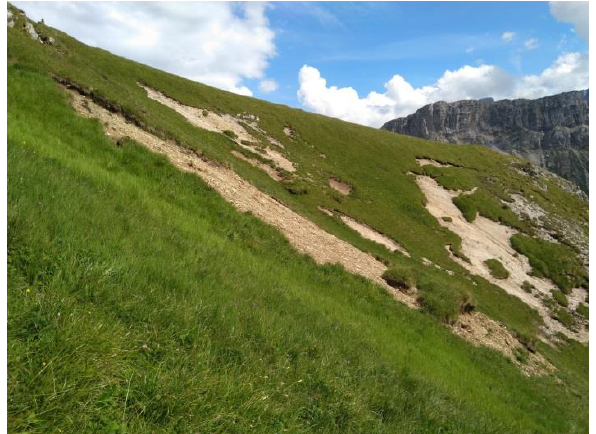
Figure 1. Example for shallow eroded areas at the test site in the Dolomites (South Tyrol, Italy).